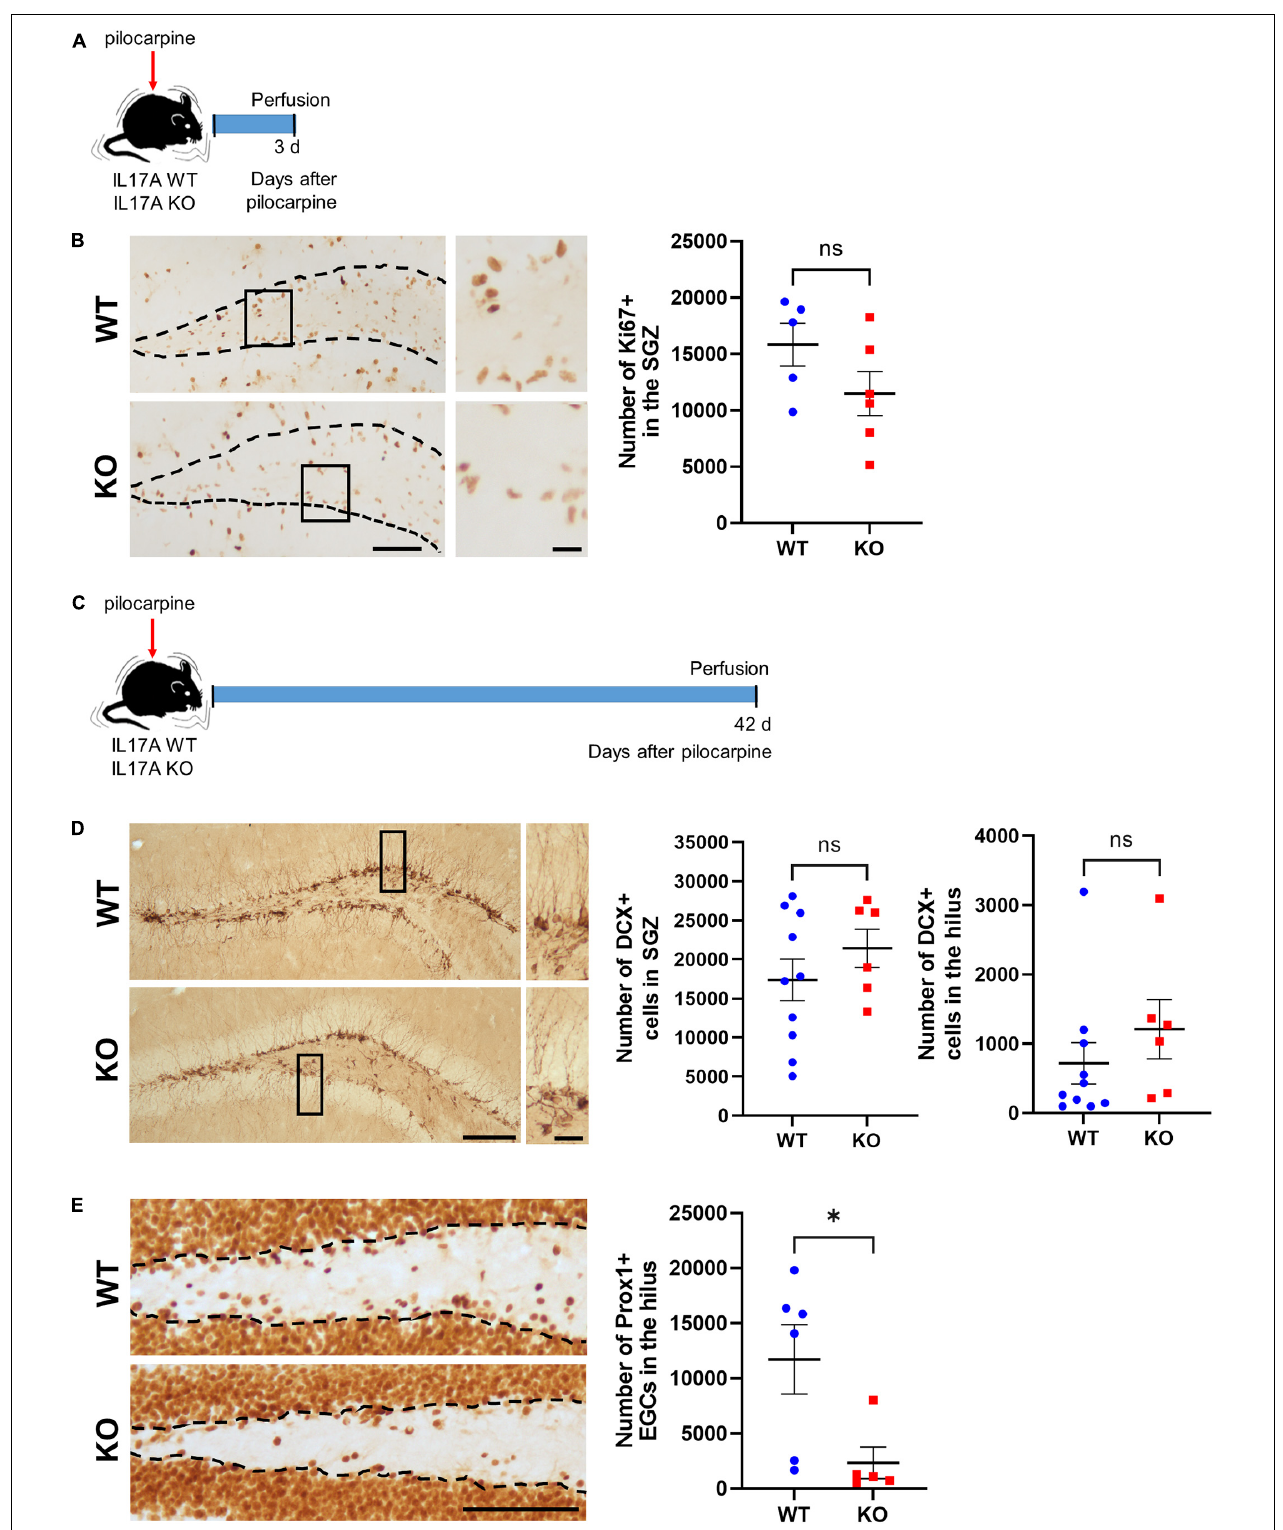
FIGURE 4 | IL-17A deficiency in mice ameliorates seizure-induced aberrant hippocampal neurogenesis. (A) Timeline showing the experimental design. (B) Representative microscope images and a graph showing immunohistochemistry for Ki67. The rectangles are magnified in the right column. The inner edge of the